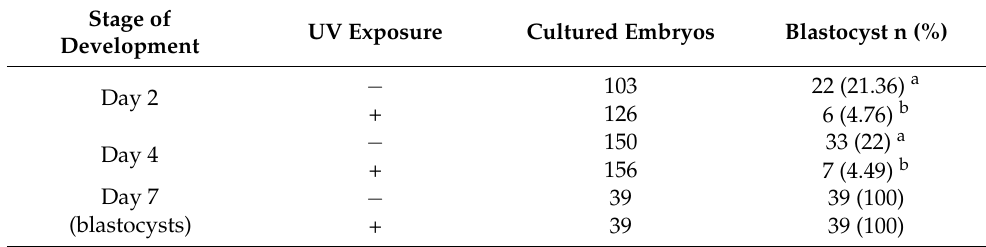
Table 1. Development of embryos that were exposed to UV light for 10